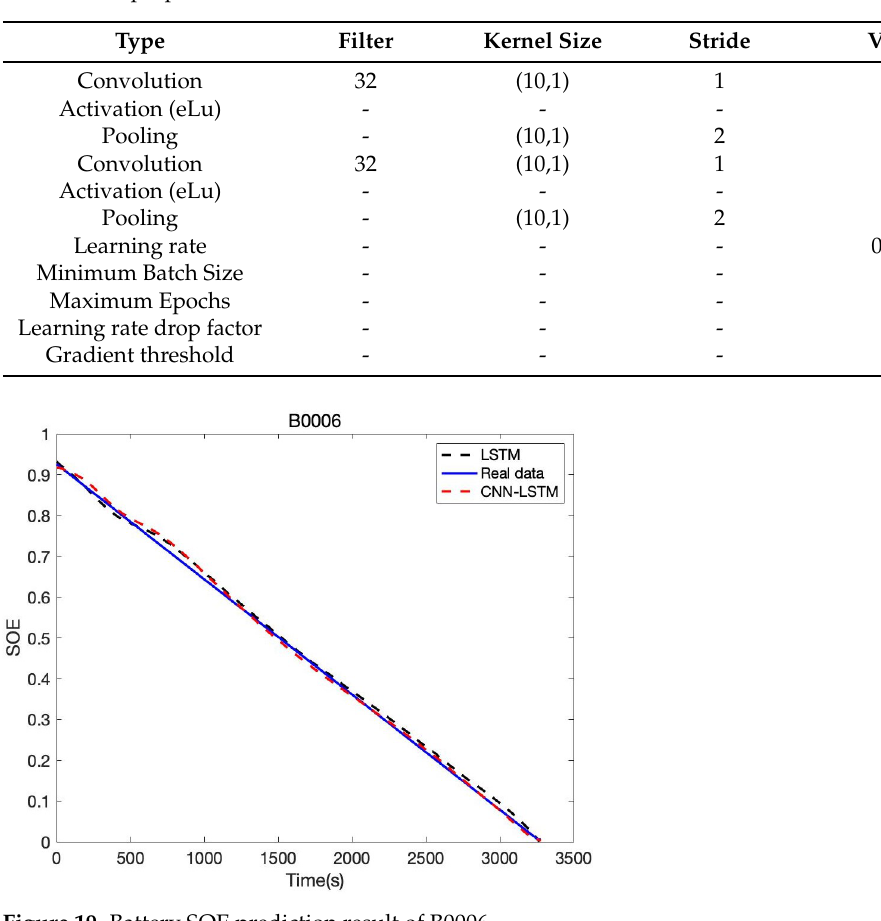
Figure 19. Battery SOE prediction result of B0006.